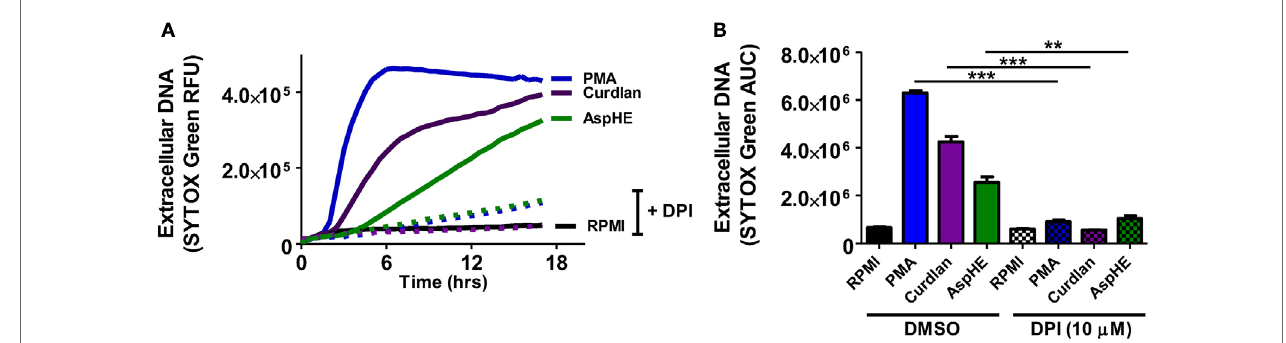
FigUre 2 | Neutrophil extracellular trap (NET) formation is dependent on reactive oxygen species (ROS). Human neutrophils were stimulated 20 h with phorbol myristic acid (PMA), AspHE, or curdlan in the presence of the ROS inhibitor diphenyl iodonium (DPI) (10 μ M). NET formation was quantified by SYTOX Green over time (a) , and total SYTOX over 18 h is shown as area under the curve (AUC) (B) . ANOVA with Tukey post hoc analysis showed *** p < 0.001 and ** p < 0.01. Experiments were repeated four times with similar